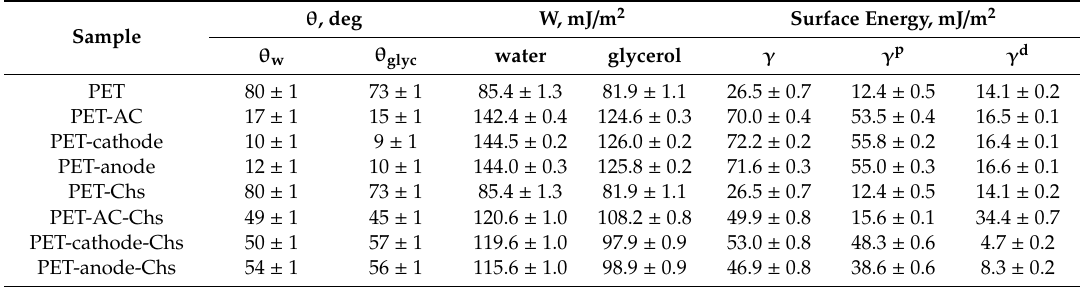
Table 1. Surface properties of the Poly(ethylene terephthalate) (PET) films treated by AC or DC plasma for 60 s as a function of discharge type.